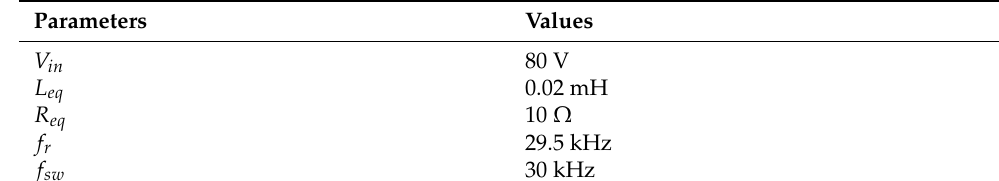
Table 1. Specifications of the bifilar coil configuration.